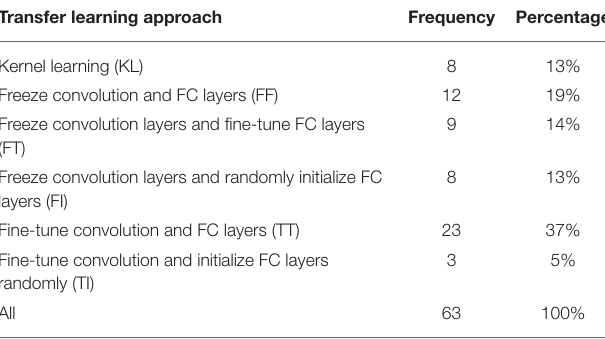
TABLE 5 | Different transfer learning